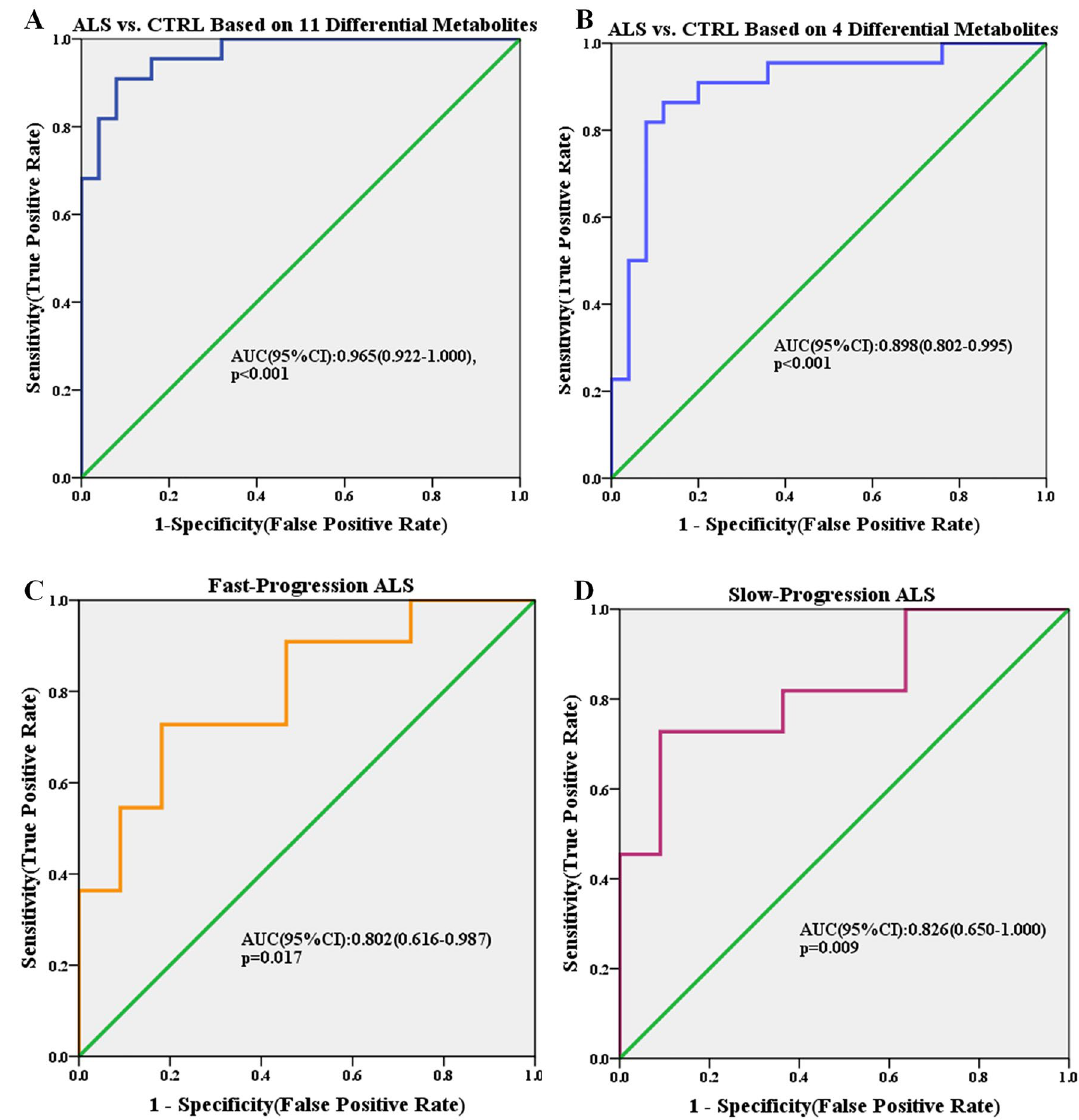
Figure 4. ROC curves of differential metabolites in the discrimination of ALS, fast-progression ALS, and slow- progression ALS